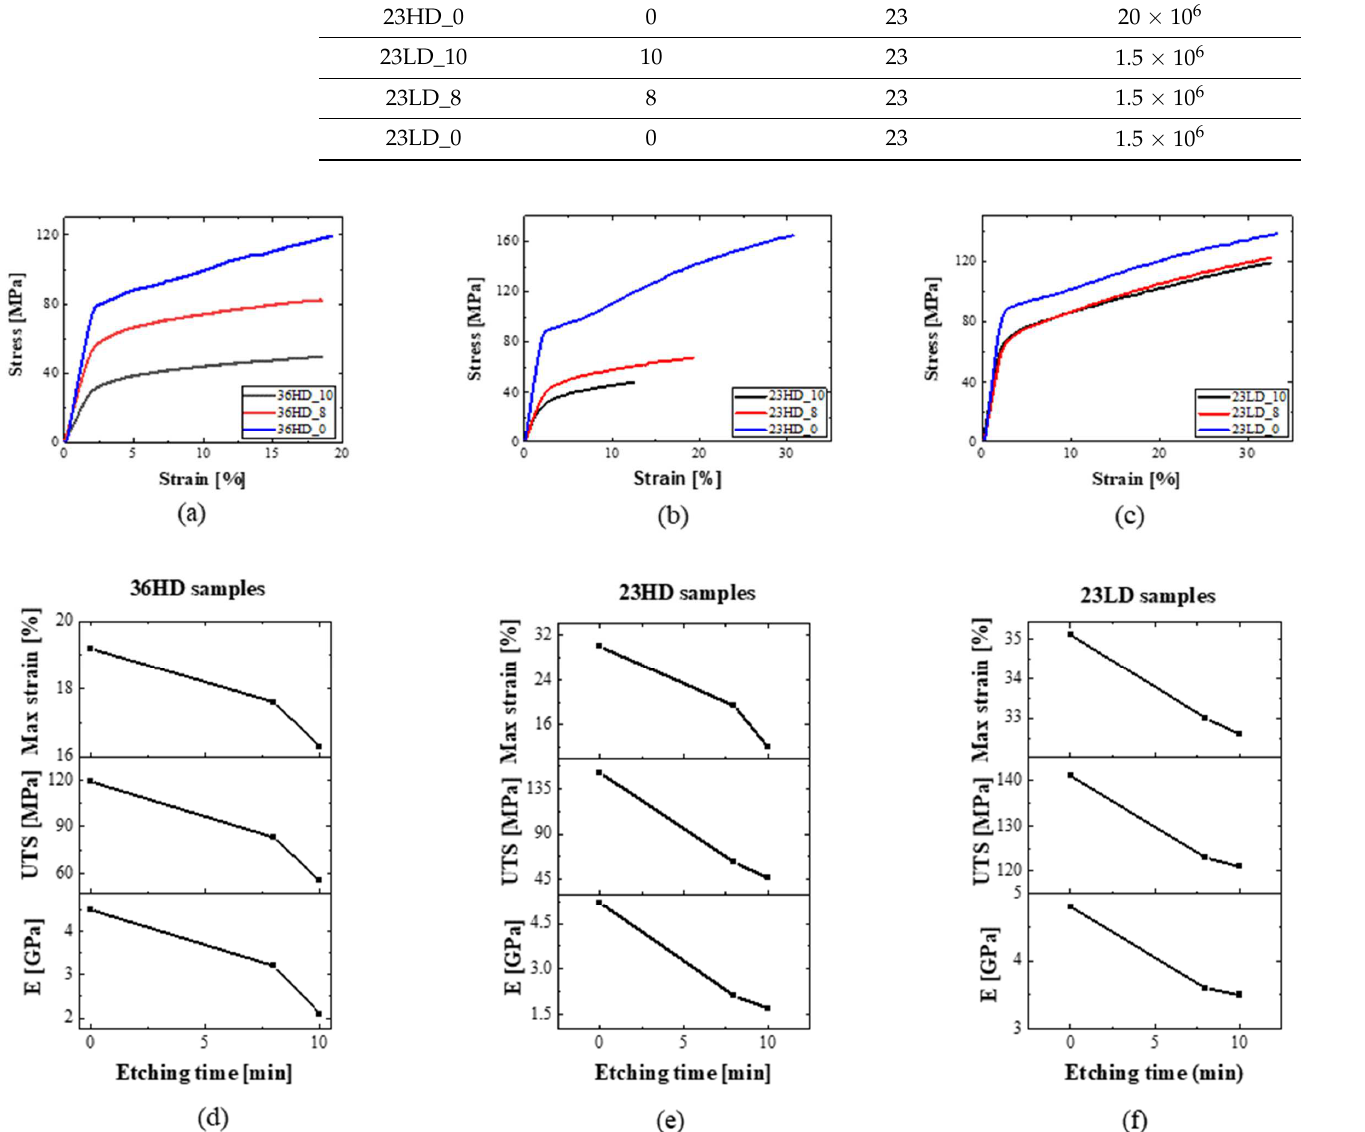
Figure 7. Characteristic stress–strain behavior of sample series ( a ) 36HD, ( b ) 23HD, and ( c ) 23LD. ( d – f ) Respective mechanical performance versus etching time.